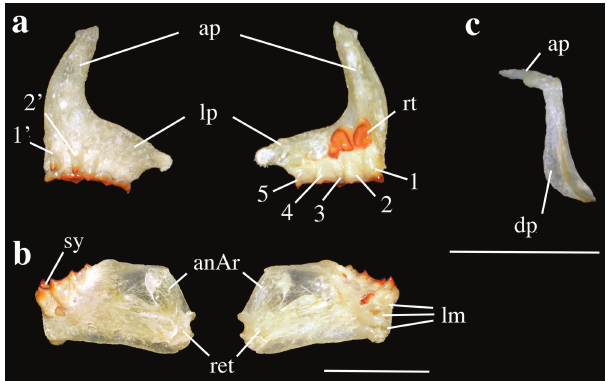
Fig. 3. Mandibular series of Metynnis melanogrammus